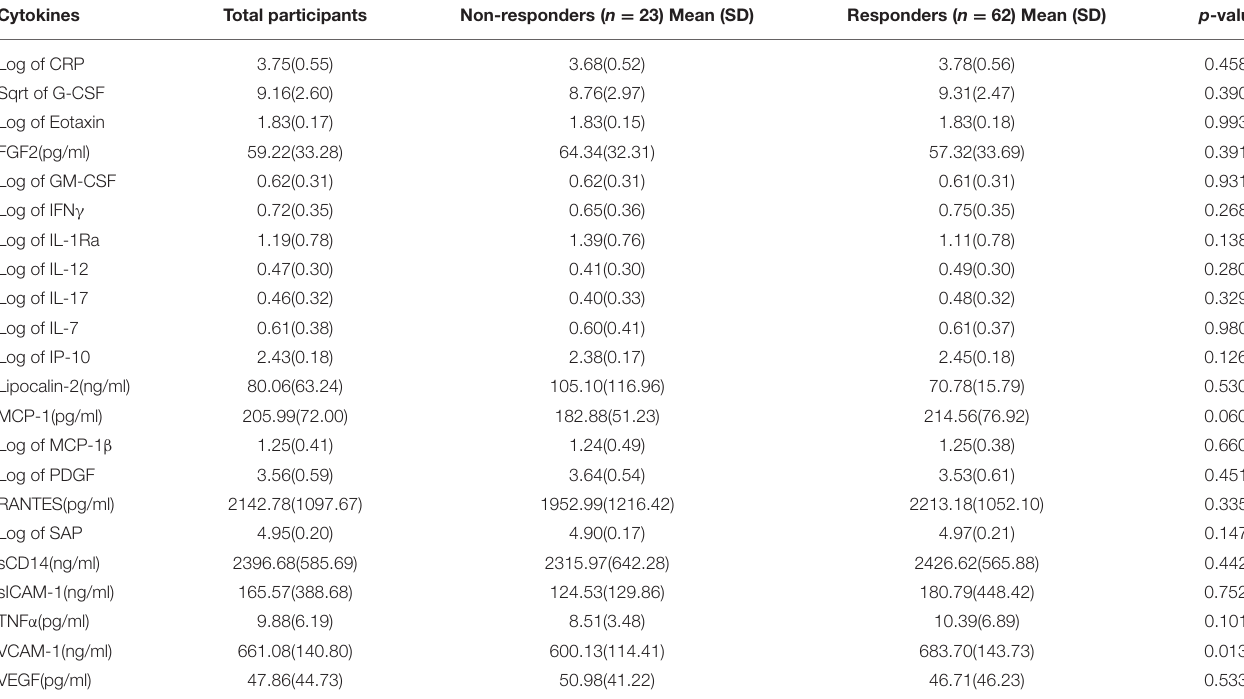
TABLE 2 | Inflammatory cytokine levels in treatment response and non-response groups.